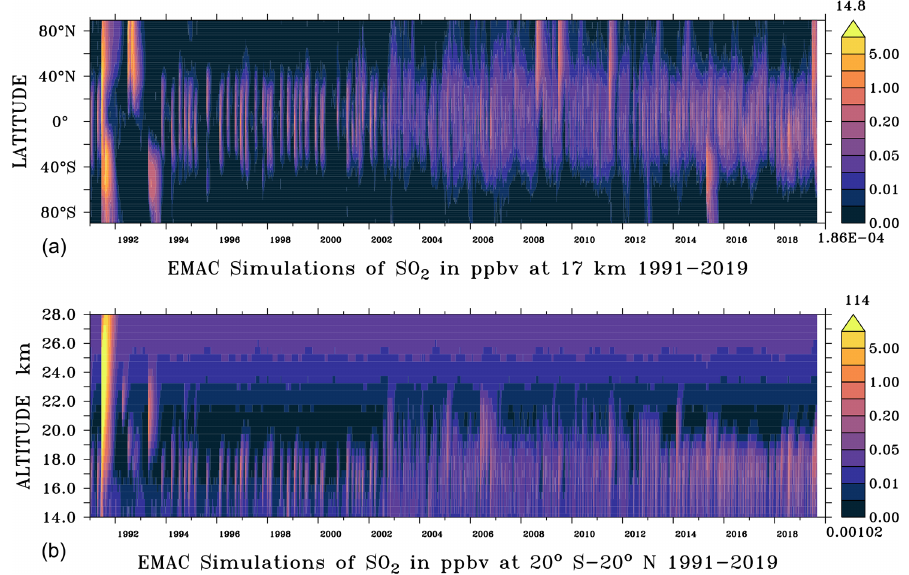
Figure 6. EMAC simulation of the stratospheric SO 2 mixing ratios (ppbv) (January 1991–August 2019, 5d averages) using the volcanic sulfur emission inventory (Table 2) at 17km altitude (a) and in vertical distribution for tropical regions 20 ◦ S–20 ◦ N (b) . Maximum and minimum values are indicated above (yellow) and below (dark blue) the colour keys,